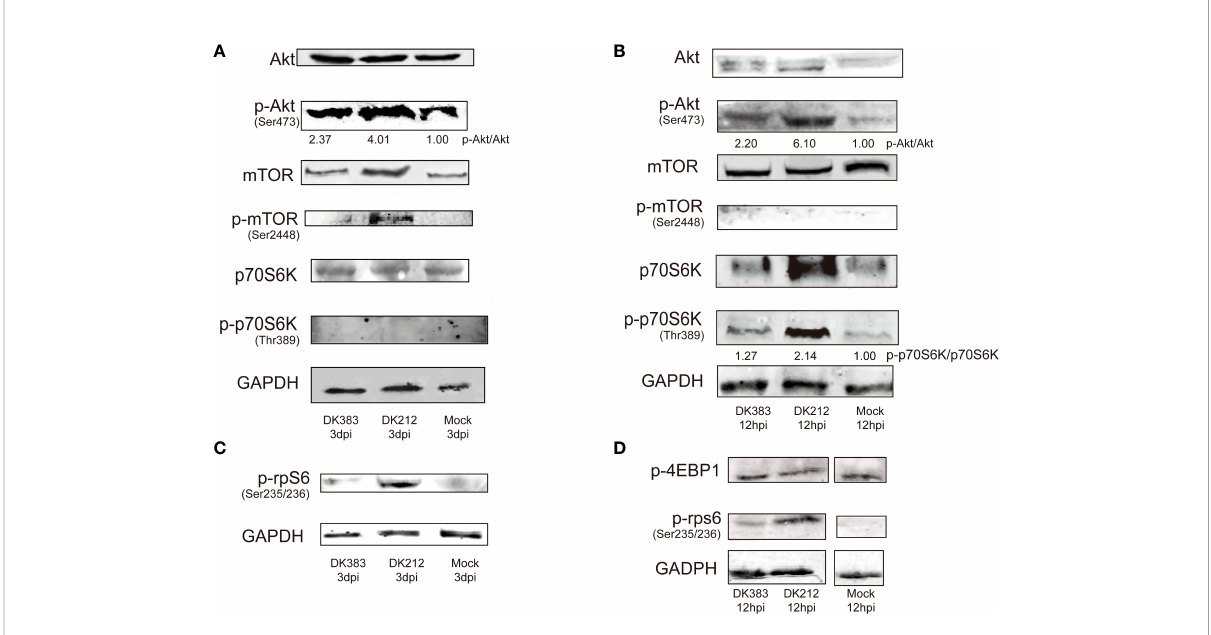
FIGURE 7 Immunoblot analysis of mTOR pathway activation in duck lung tissues at 3 dpi DEF lysates at 12 hpi infected with DK383 or DK212. Total and phosphorylation levels of Akt, mTOR, and p70S6K are shown in lung tissues (A) and DEF (B) ; (C) shows phosphorylation of rpS6 in lung tissues; (D) shows phosphorylation of 4EBP1 and rpS6 in infected DEF. Densitometry of signal intensity of the phosphorylation protein normalized to the corresponding total protein was labeled under each band. The mock-infected group was used as the negative